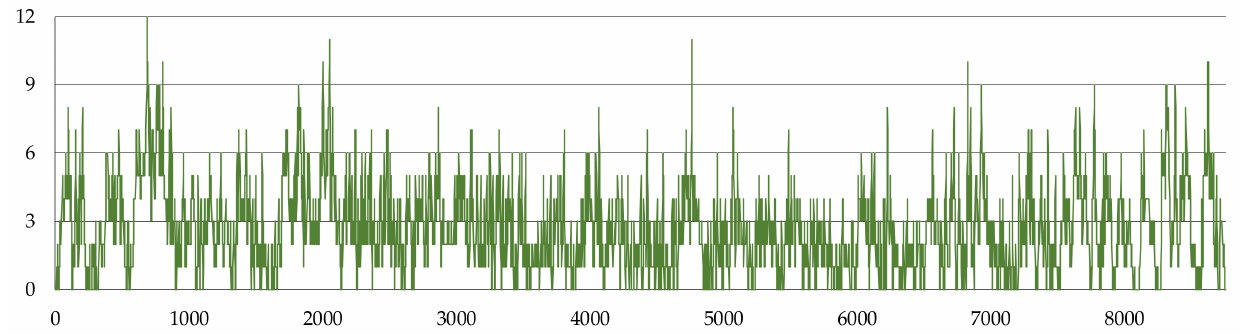
Figure 8. Wind speed (m/s) during the typical meteorological year for the Katowice meteorological station.